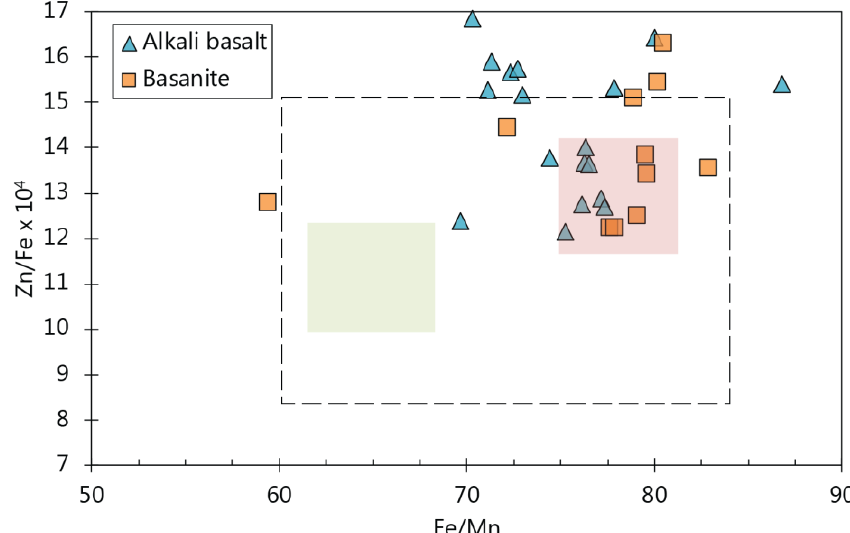
Figure 8. Zn / Fe of Buckland olivine phenocrysts plotted against Fe / Mn. Fields are from Yang et al. [2]. The red box indicates olivines crystallised from a melt derived from a sheared lherzolite (PHN 1611) source assemblage [77], the green box represents olivines crystallised in a melt derived from primitive mantle peridotite composition [78], and the dashed box represents olivines from a wide range of peridotite-derived melts [2]; areas outside this dashed box have been interpreted as indicating pyroxenite assemblages. Buckland olivine phenocrysts had high values for both Zn / Fe and Fe / Mn, probably indicating the source assemblage was pyroxene-rich and contained olivine.